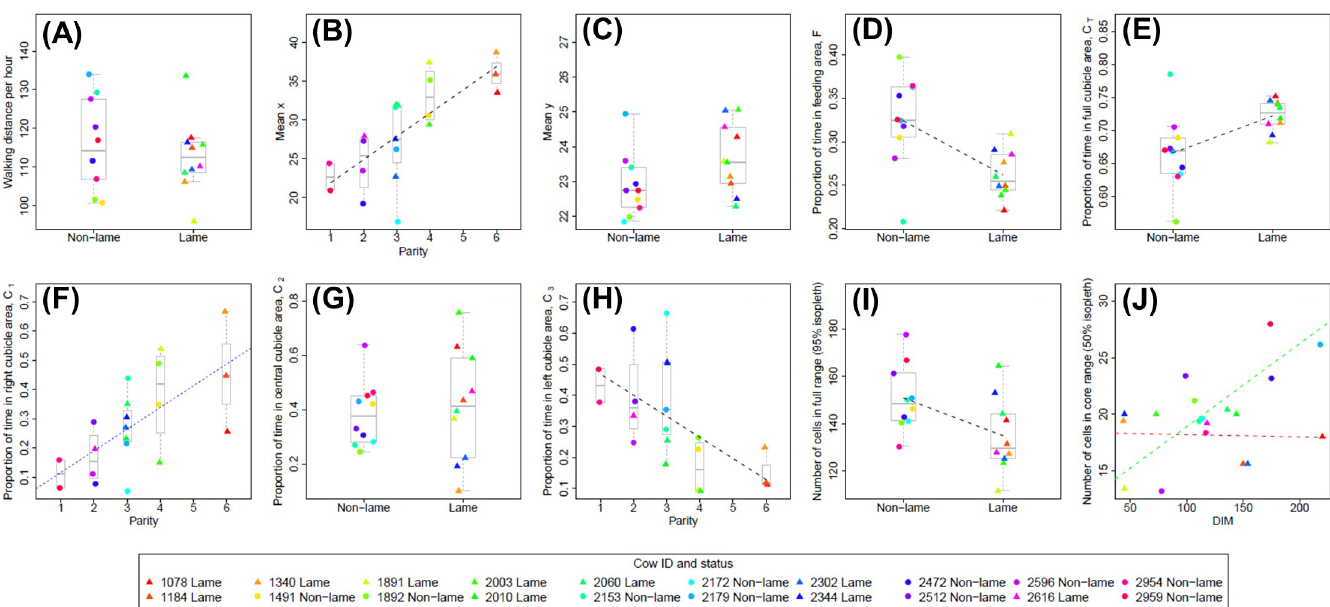
Fig 3. Plots showing relationship between significant predictor variables (lameness; parity; days in milk, DIM) and basic space-use measures. Data for each basic space-use measure, S to S , are shown in plots (a) to (j) respectively, and are plotted against the most significant predictor variable determined from the model 1 10 selection procedure (Table 1). Where none of the predictor variables are significant (at the 5% level) for a given model, the data is plotted for the lame and non-lame groups (a, c, g). Where appropriate, boxplots (with median line) are used to show the spread of the data for each level of the predictor variable (a–i). Individual data points are calculated as a mean average across all five days of the trial for each cow (S2 Table). Lame cows are plotted as filled triangles and non-lame cows as filled circles; the colours used to indicate each data point are fixed for each cow and are consistent across all plots (see legend). Where the best fitting linear model includes only a single predictor variable, the fitted regression line is shown as a dashed black line (b, d, e, h, i). In (f) the best fitting linear model includes both parity and DIM terms (Table 1); a regression line fitted only to the parity variable (the most significant predictor) is shown as a blue dashed line for illustrative purposes only. In (j), the best fitting linear model includes lameness, DIM, and an interaction term; regression lines fitted only to the DIM variable are shown for the lame group (red dashed line) and non-lame group (green dashed line) to illustrate the negative interaction of lameness with DIM.